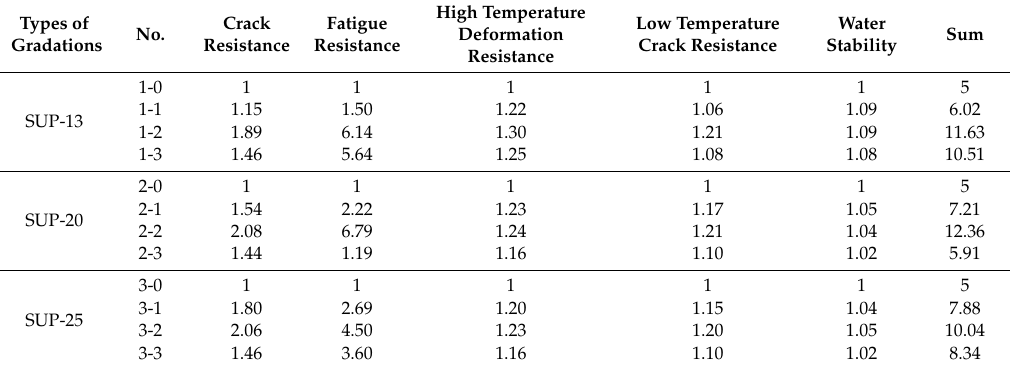
Table 5. The results of the normalization method.